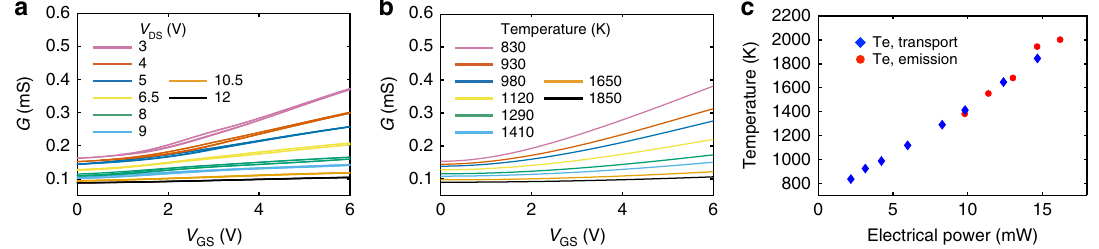
Fig. 3 Electrical transport of hot graphene electrons. a Gate-dependent conductance of the graphene device measured at different V DS voltages. The elevated electronic temperature of graphene due to applied V DS voltages results in the weaker variation of the conductance via electrostatic gating. b Theoretical calculation of the graphene conductance with different electronic temperatures. c The electron temperature of the graphene extracted from thermal emission spectra (red circles) and electrical transport model (blue diamonds) the emission spectra that are collected at polarization angles parallel cavity. The blue dashed line in Fig. 2b shows a calibrated blackbody ( ϕ = 0°) and perpendicular ( ϕ = 90°) to the x -axis of the cavity. The spectrum at T BB = 2000 K, matching the measured peak intensity of intensity of the thermal emission collected at ϕ = 0° shows a strong, the cavity-graphene emitter at V DS = 13 V. From the radiation peak 15-fold enhancement compared with that collected at ϕ = 90° at the intensity I ( ω 0 ) of the graphene emitter at different bias voltages resonant wavelength of 1585 nm. The polar plot in the inset of ( V DS ), it is possible to extract the electron temperatures of graphene Fig. 2c shows the emission intensity with respect to the angle ϕ at with respect to V DS , as the red circles shown in Fig. 3c. the resonant (cyan) and non-resonant (purple) wavelengths. A clear Figure 2c shows the polarization-dependent intensity of the polarization-dependent on-resonant emission spectrum that varies thermal emitter with V DS = 13 V. The red and blue curves represent NATURE COMMUNICATIONS| (2019) 10:109